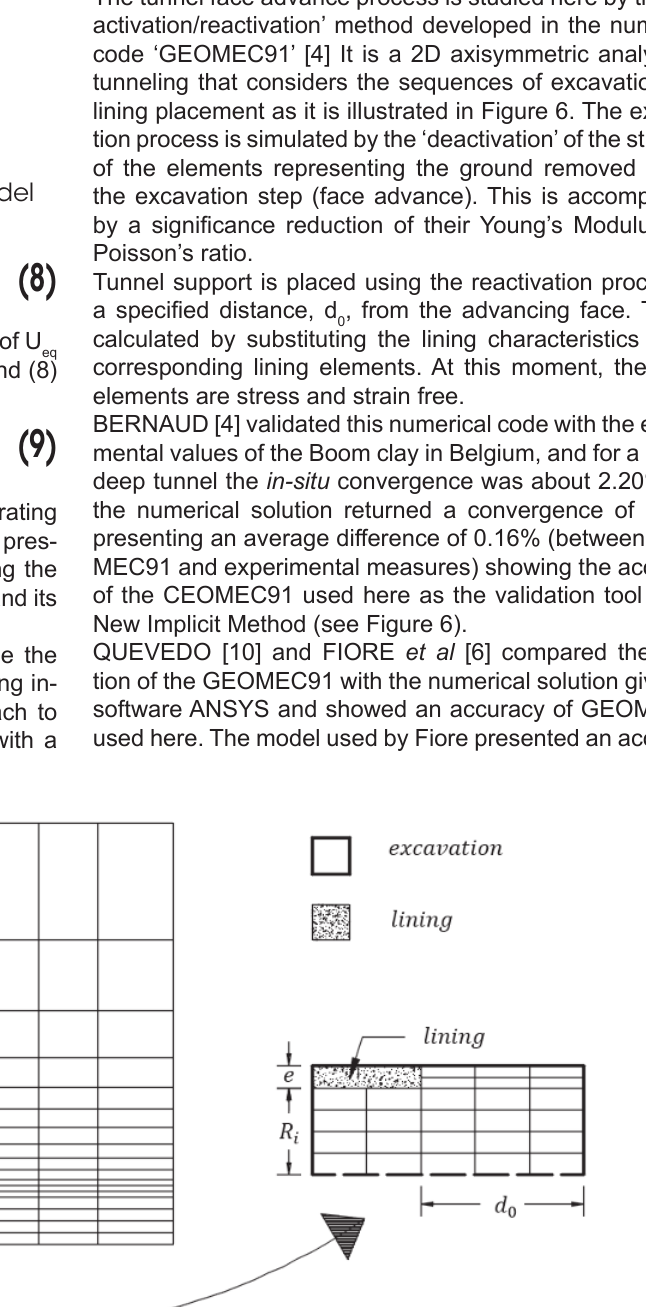
in a plane strain 0